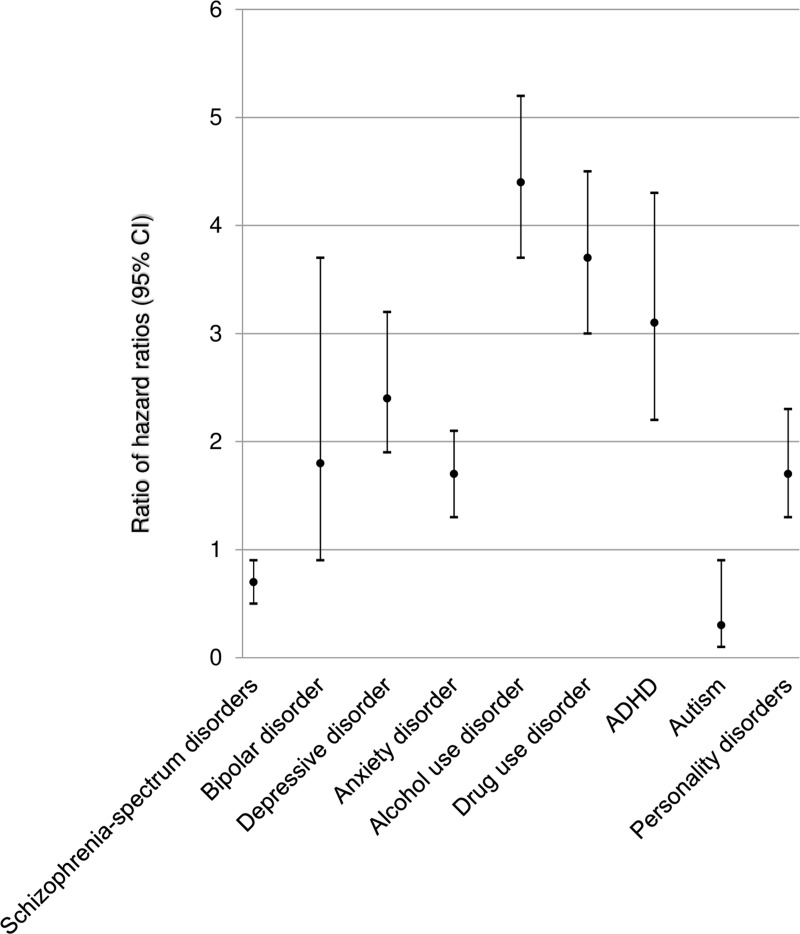
Ratio of hazard ratios (men with mental disorders versus siblings) of intimate partner violence against women.The ratio of hazard ratios is the hazard ratio for individuals with mental disorders versus 20 age- and sex-matched general population controls divided by the hazard ratio for unaffected siblings versus 20 age- and sex-matched general population controls. The bars represent the 95% confidence intervals. ADHD, attention deficit hyperactivity disorder.